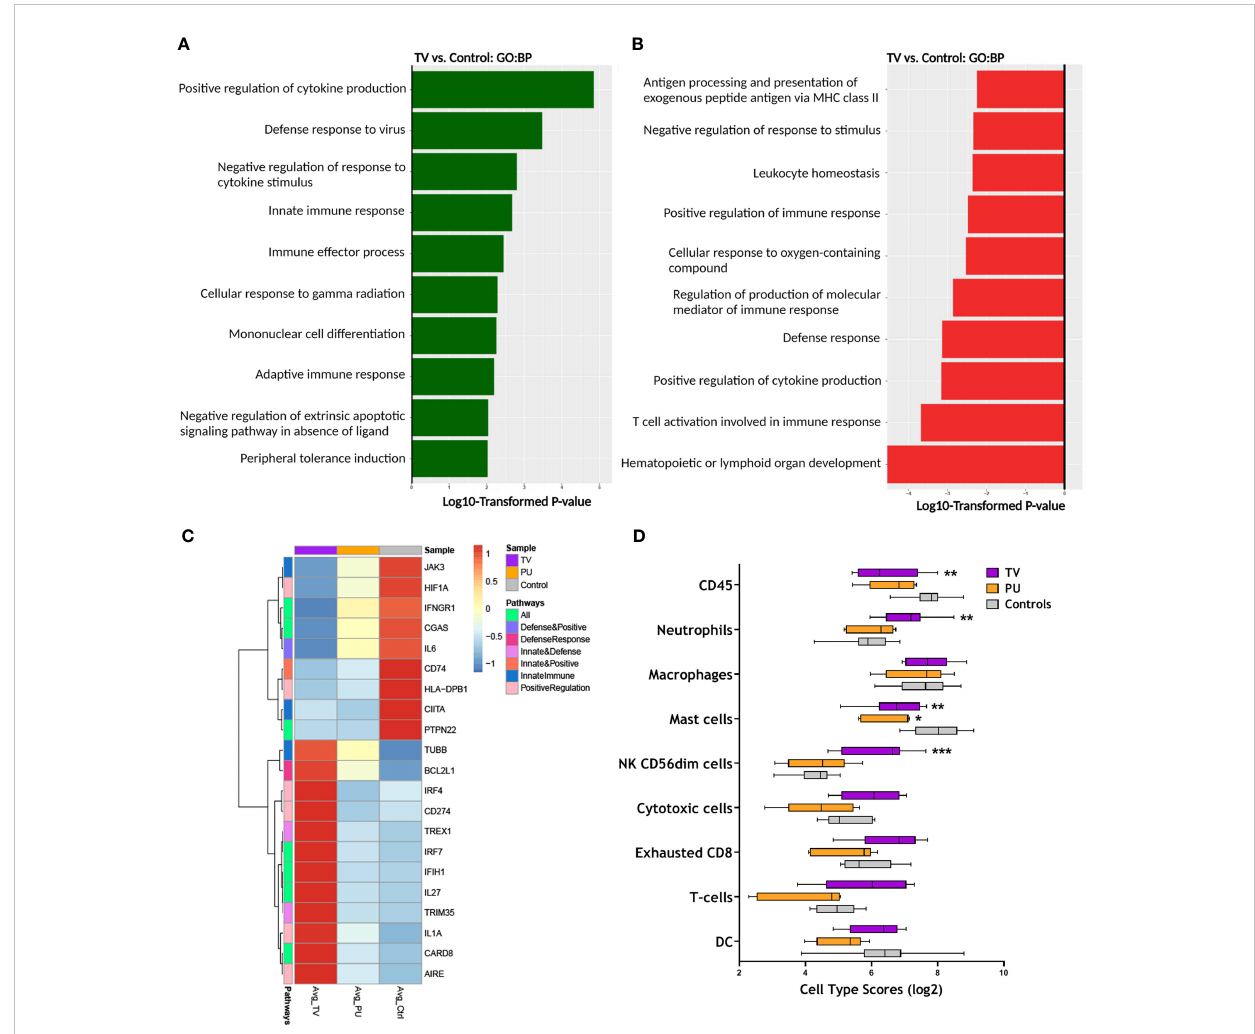
FIGURE 3 RNA expression reveals distinct immune responses in TV ulcers. (A) Top enriched GO biological pathways (N=10) in COVID-19(+) TV (TV) samples compared with COVID-19(-) PU (Control). (B) Top GO biological pathways (N=10) downregulated in TV samples relative to controls. (C) Clustered heatmap comparing average normalized counts of COVID-19(+) TV and COVID-19(+) PU (PU) groups with COVID-19(-) PU Control samples depicts differentially expressed genes (FDR adjusted p -value of <0.05) involved in positive regulation of cytokine production, defense response to virus, and innate immune response pathways. Genes involved in pathways were identi fi ed from GO biological pathways (D) Box and whisker plot shows the relative immune cell type scores of TV, PU, and Control samples. Cell type scores were determined using NanoString Advanced